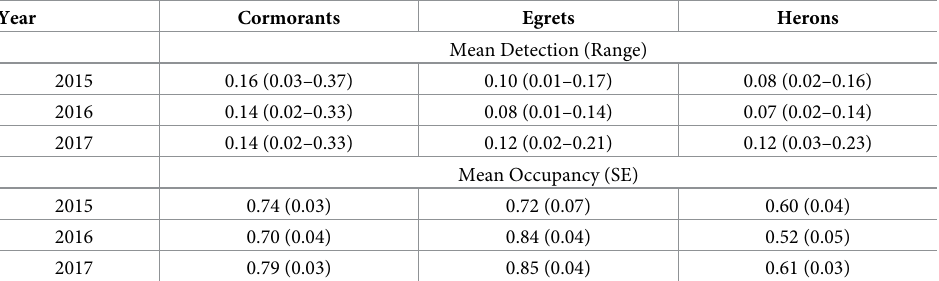
Table 4. Average yearly detection and occupancy rates for cormorants, egrets, and herons on catfish ponds in the Mississippi Delta. Detection varied by date, and the resulting range of detection probabilities are shown. These detec- tion rates represent the probability of observing these species on a pond given the pond is being used, and are only rep- resentative of the survey methods described within this